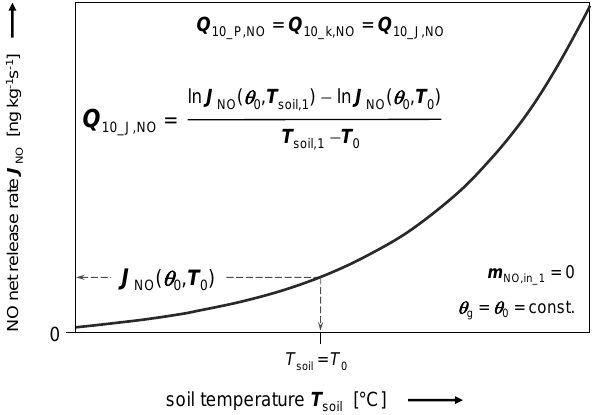
Figure 1. Schematic of NO net release rate J NO vs. NO mix- ing ratio m NO , cham in the headspace of the dynamic cham- Fig. 1: Schematic of NO net release rate J NO vs . NO mixing ratio m NO,cham in the 4 ber at constant soil temperature and soil moisture; different in- headspace of the dynamic chamber at constant soil temperature and soil 5 dices on NO mixing ratios at the inlet ( m NO , in ) or within moisture; different indices on NO mixing ratios at the inlet ( m NO,in ) or within 6 the dynamic chamber ( m NO , cham ) are explained in the text the dynamic chamber ( m NO,cham ) are explained in the text (note: m NO,cham_2 < 7 (note: m NO , cham_2 < m NO , in_2 , if m NO , cham_2 > m NO , comp , and m NO , cham_2 > m NO , in_2 , if m NO , cham_2 < m NO , comp ). m NO,in_2 , if m NO,cham_2 > m NO,comp , and m NO,cham_2 > m NO,in_2 , if m NO,cham_2 < 8